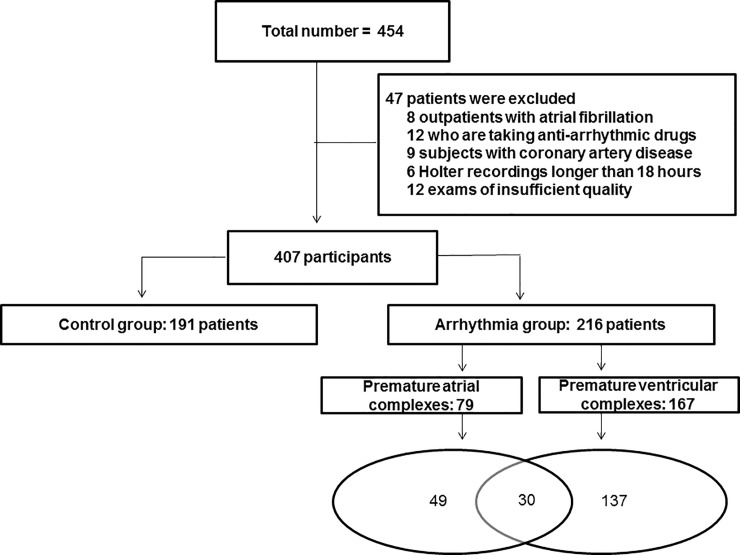
Flowchart showing the classification of patients.